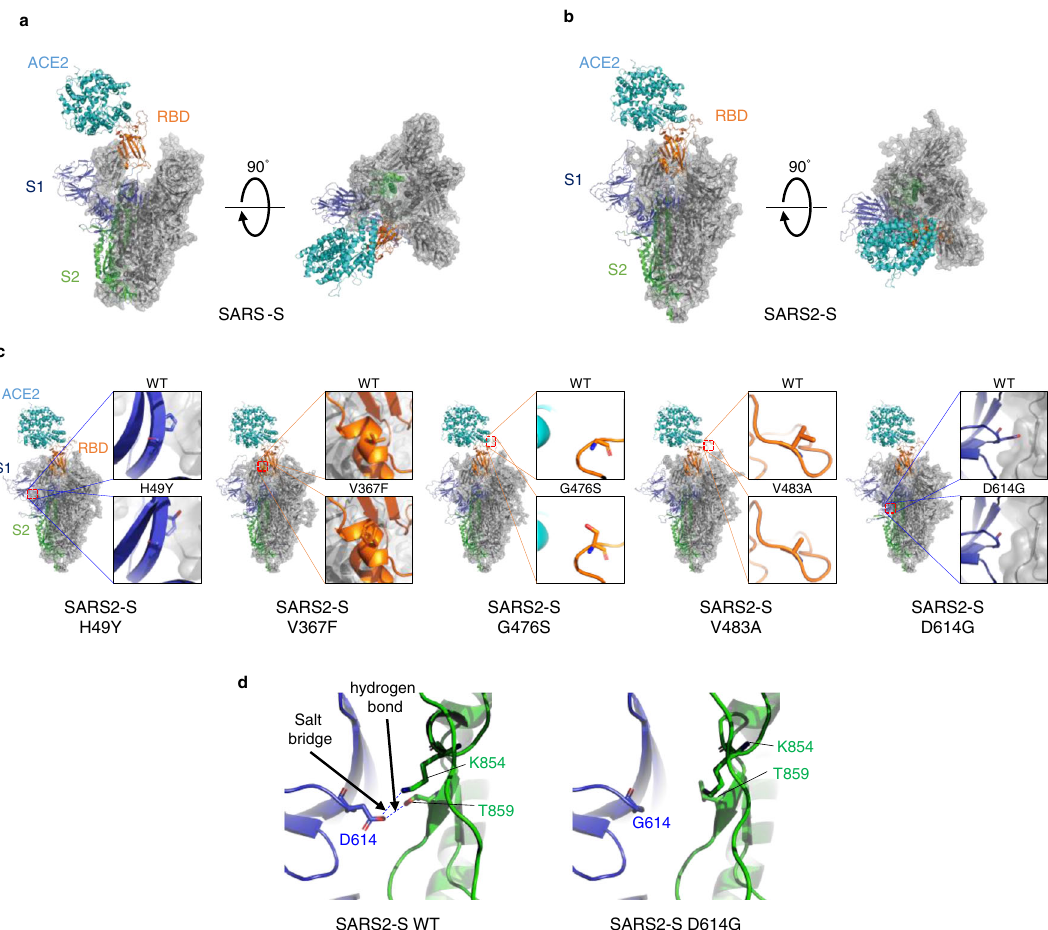
Fig. 3 SARS2-S D614G protein shows the prominent structural difference. a , b Trimeric structure of the S proteins from SARS-CoV ( a ) and SARS-CoV-2 ( b ) that bind to the host receptor ACE2 (cyan). One protomer of the S protein is shown as a ribbon in navy (S1 subunit), orange (receptor-binding domain (RBD) in S1 subunit), and green (S2 subunit), while two other protomers are shown as gray transparent surfaces and ribbons. The structures are viewed from two different angles. c Comparison between wild-type (WT) and mutant S proteins from globally spread SARS-CoV-2 variants. ( Inset ) Enlargement of the region in which each amino acid is mutated, with comparison with the WT S protein. H49Y ; as the histidine at position 49 is located distant from the RBD and putative cleavage sites, the effect of this mutation on S ’ s function is likely limited. V367F ; the substitution from a valine to a phenylalanine at position 367 in the RBD introduces a larger side chain at a protomer – protomer interface, which might provide a more rigid RBD structure. G476S ; the substitution at position 476 in the RBD results in a protruded surface, which appears to interfere with the ACE2 – RBD interaction. V483A ; both valine and alanine residues have short side chains, likely sharing similar phenotypes. D614G ; details are depicted in Fig. 3d. Note that these structural bases are largely consistent with the results of cell entry activity shown in Fig. 2b. d Structural difference between WT and D614G SARS-CoV-2 S proteins. WT (left); an aspartic acid (D614) in the S1 subunit (navy) of a protomer binds to a threonine (T859) and/or a lysine (K854) in the S2 subunit (green) of the other protomer though electrostatic interaction between the pairs of these residues. D614G (right); the short nonpolar side chain of glycine (G614), which does not bind to T859 and K854, provides fl exible space between the two protomers. The fi gures were drawn with PyMOL ver. 2.4